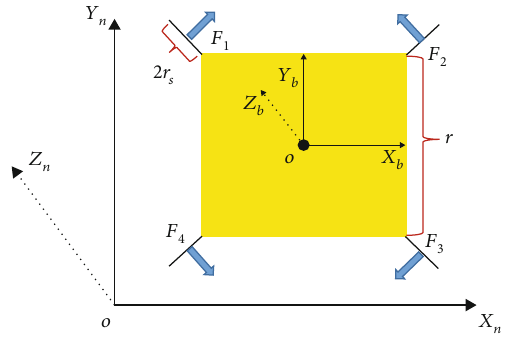
Figure 3: Top view of air fl otation